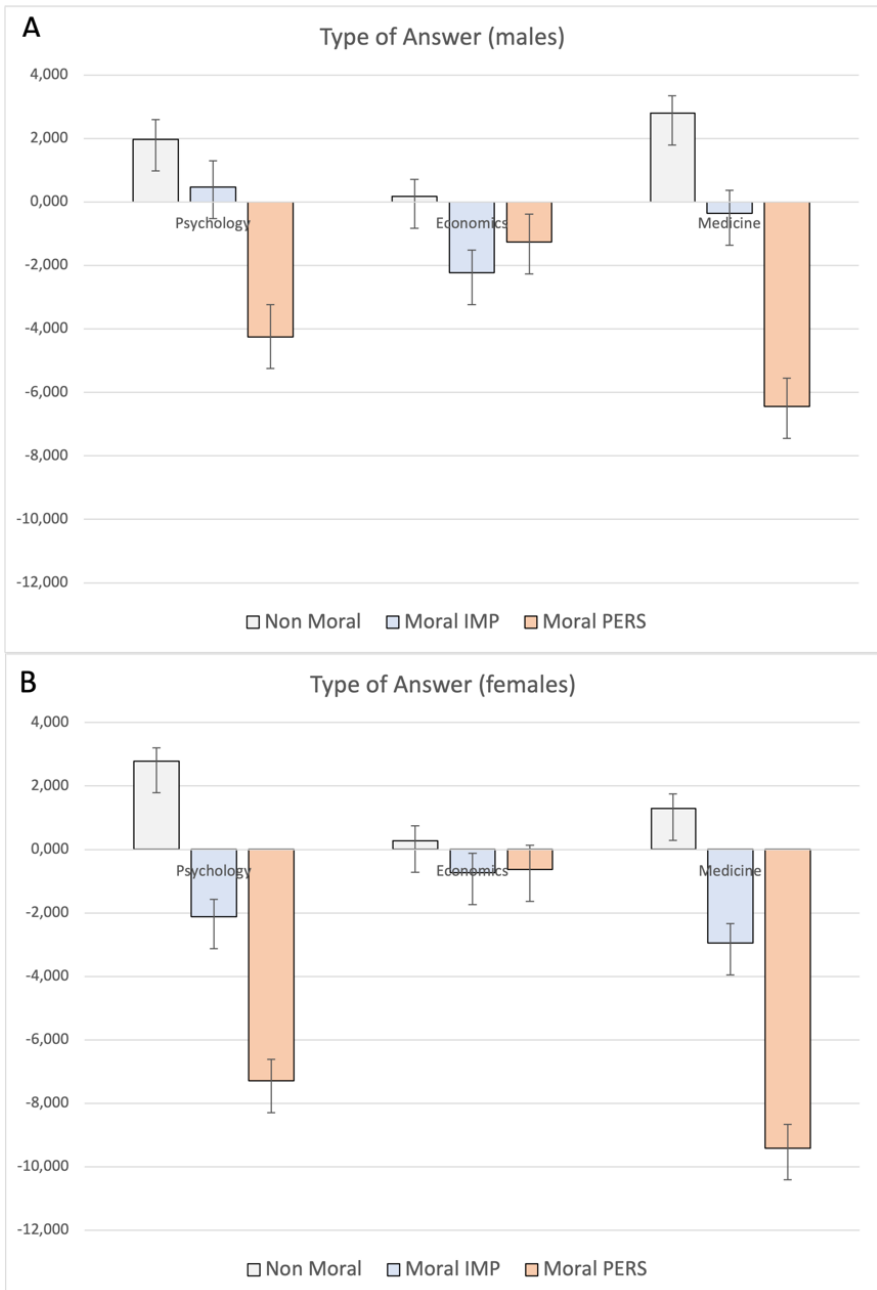
Figure 2. MANCOVA results on Type of Answer: significant interaction school x sex. Panel ( A ): males; panel ( B ): females. Note: the y-axis shows the difference between the number of appropriate vs. inappropriate judgments.